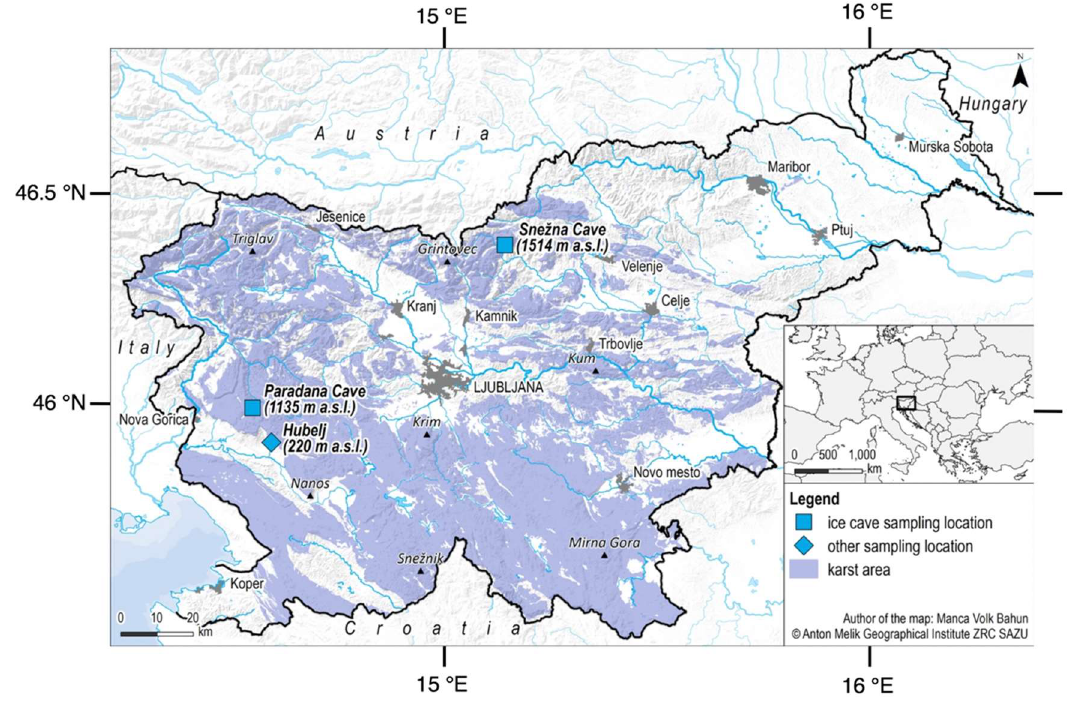
Figure 1. Map showing the location of studied ice caves in Slovenia.